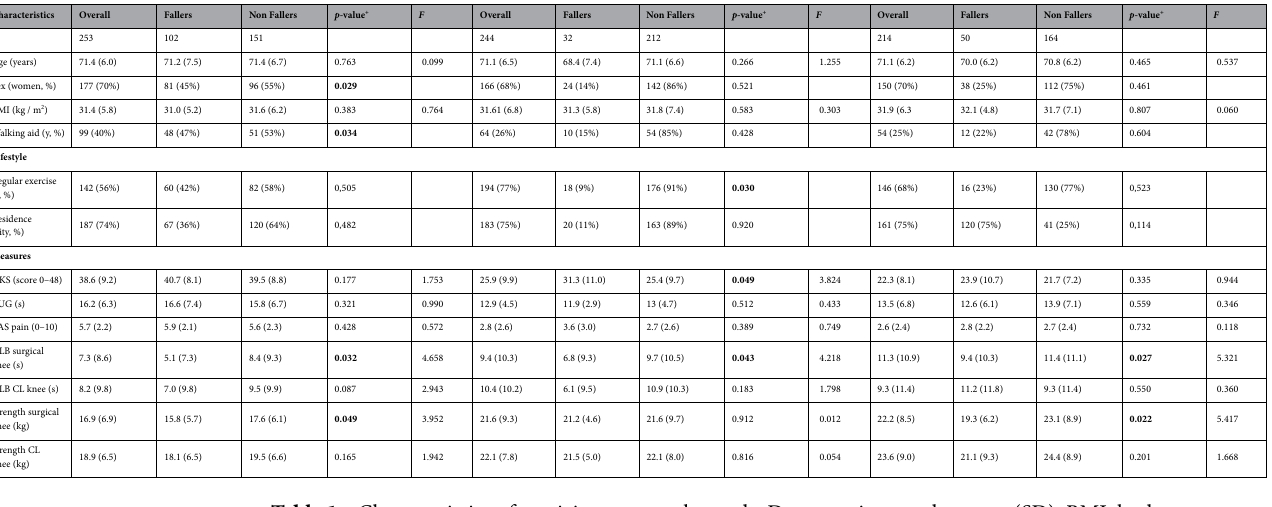
Table 1. Characteristics of participants over the study. Data are given as the mean (SD). BMI, body mass index; OKS, oxford knee score; TUG, timed up and go; VAS, visual analogue scale of pain; OLB, one-leg stand balance test; CL, contralateral + p -value of F-test or Chi-square test for continuous or categorical variables, respectively. Significant values are in